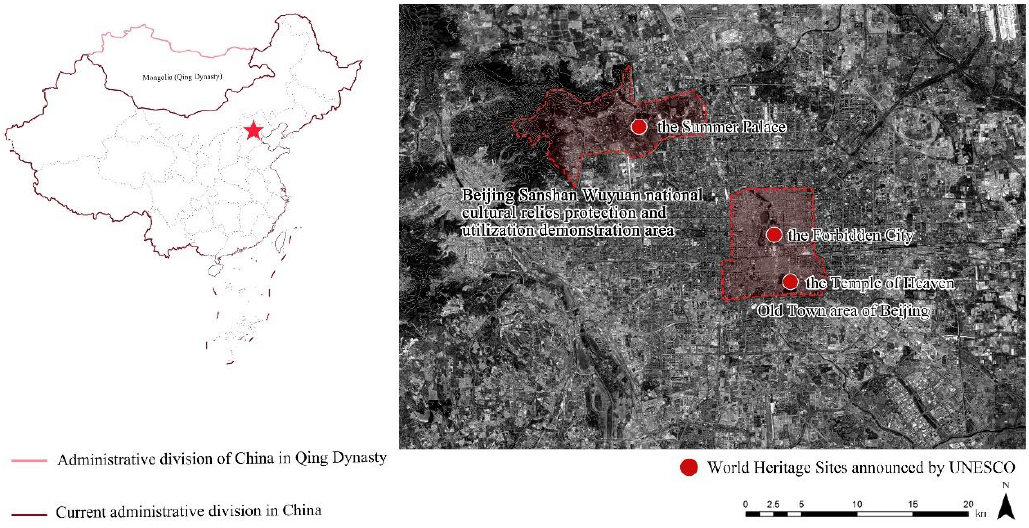
Figure 1. Protected area with the study area and location of Beijing [5].